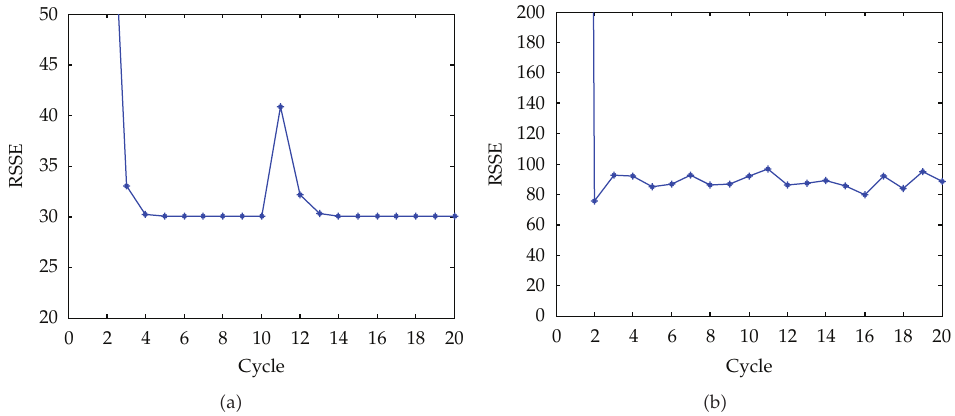
Figure 3: (cid:2) a (cid:3) Tracking performances in Case 1. (cid:2) b (cid:3) Tracking performances in Case